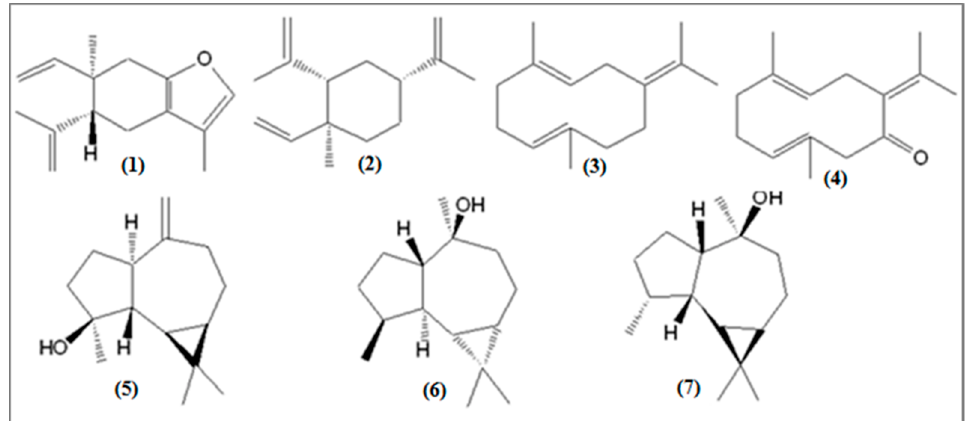
Figure 4. Other sesquiterpene compounds identified in the oils of Eugenia uniflora : ( 1 ) curzerene, ( 2 ) β -elemene, ( 3 ) germacrene B, ( 4 ) germacrone, ( 5 ) spathulenol, ( 6 ) globulol, ( 7 ) viridiflorol.